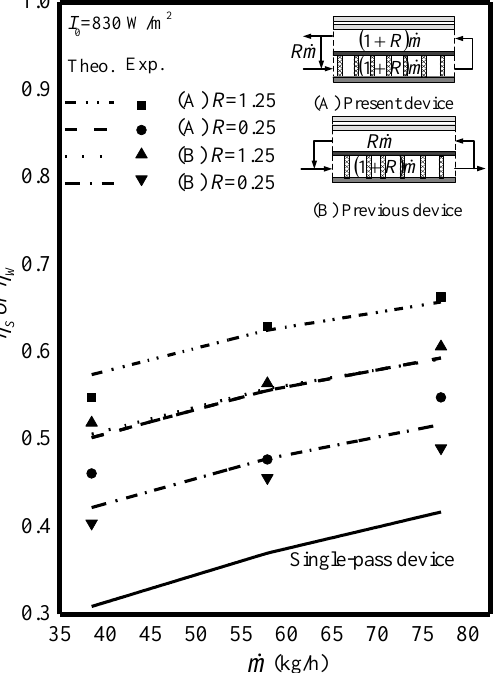
Figure 6. Comparisons of collector efficiency between the present and previous work [26]. Copyright 2013